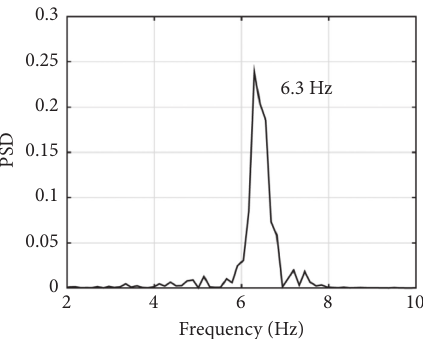
Figure 8: PSD of lift coefficient (with spoilers).